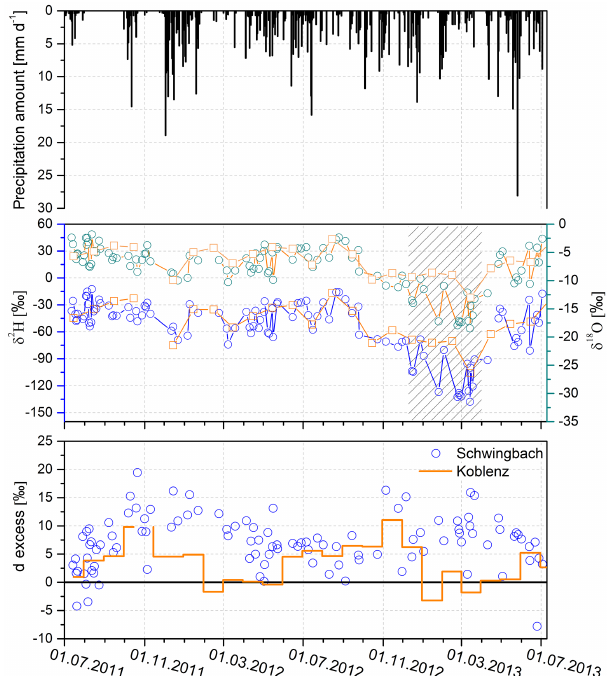
Figure 2. Temporal variation of precipitation amount, isotopic sig- natures ( δ 2 H and δ 18 O) including snow samples (grey striped box) of the Schwingbach and GNIP station Koblenz, and d-excess values for the study area compared to monthly d-excess values (July 2011 to July 2013) of GNIP station Koblenz with reference d excess of GMWL (d = 10; solid black